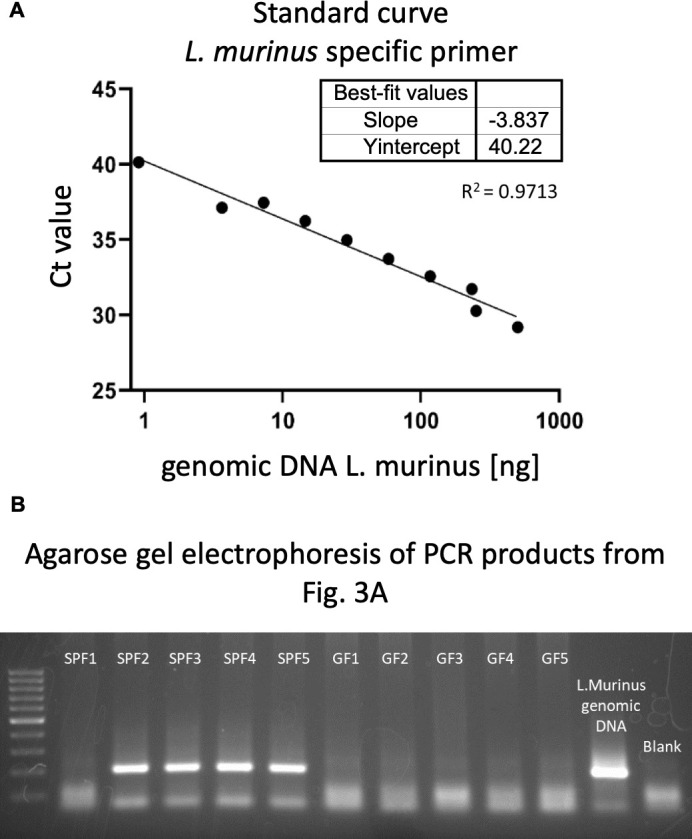
Quality controls for L. murinus specific qPCR.(A) Standard curve for L. murinus-specific qPCR using DNA from a defined number of CFU of a L. murinus culture in log phase. (B) Amplicons of qPCR were loaded on a standard agarose gel and stained with 0.1 ethidium bromide.